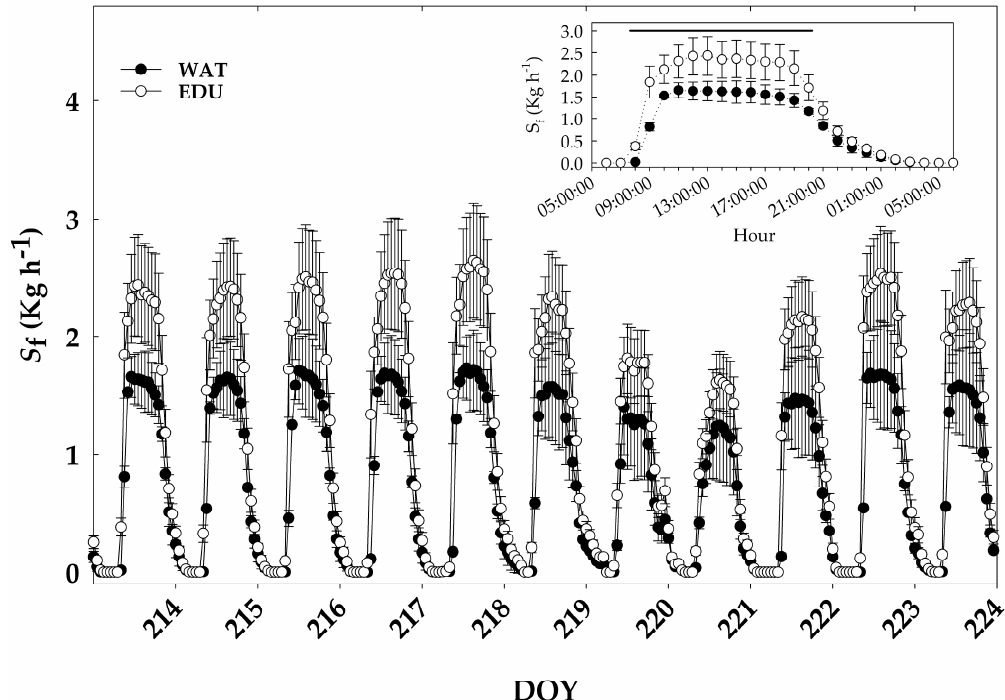
Figure 5. Time series of hourly sap flow (±SD) from DOY 214 to DOY 224 in WAT (water treated) and EDU (EDU treated) trees ( N = 5 trees). The inset shows the mean hourly sap flow, S f , (±SD) calculated over this 10-day time window. The black horizontal line represents the significant differences between means for p < 0.05 ( t -test).